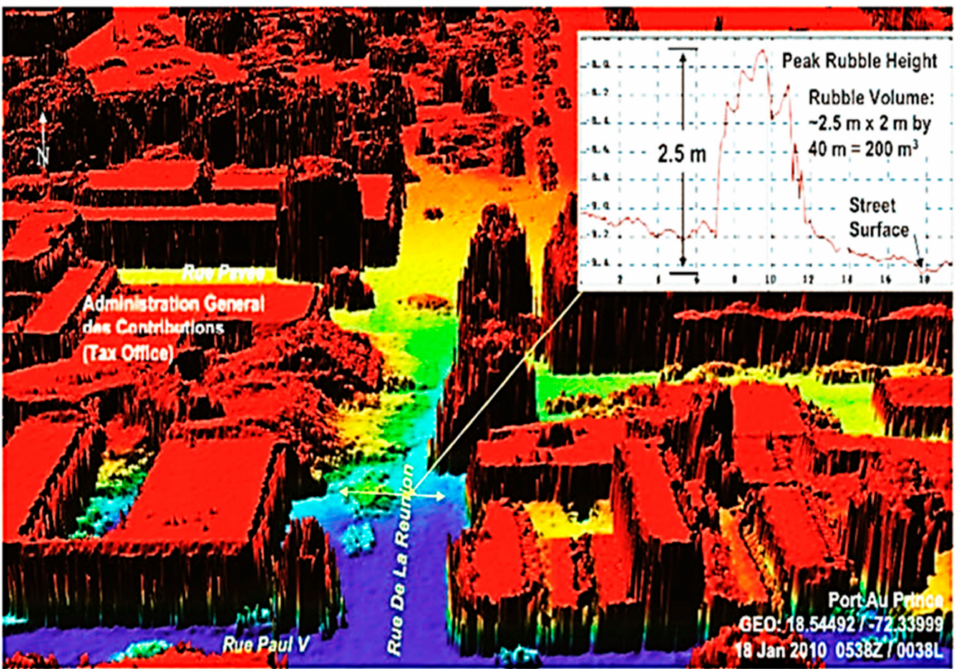
Figure 2. In Haiti 2010, Airborne LiDAR Imaging Research Testbed’s (ALIRT’s) direct and precise measurement of height and slope helped inform which type of vehicles may navigate